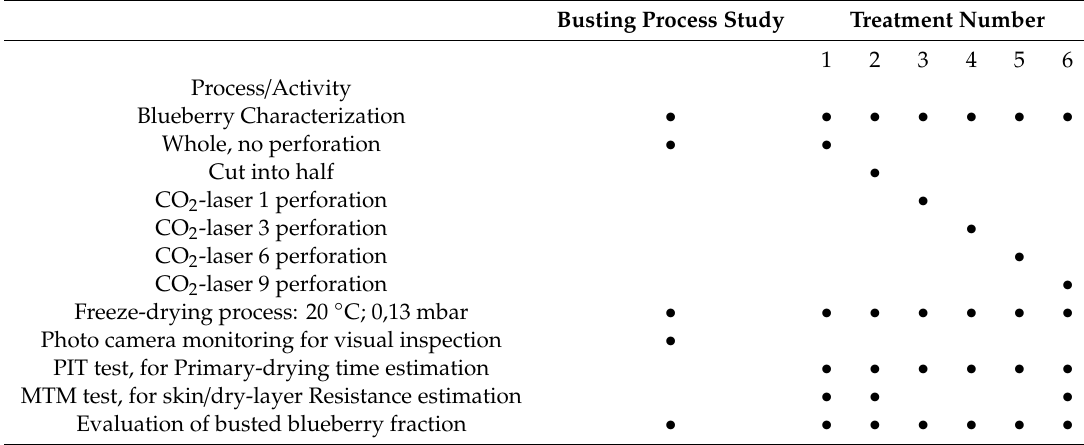
Table 1. Description of the experimental